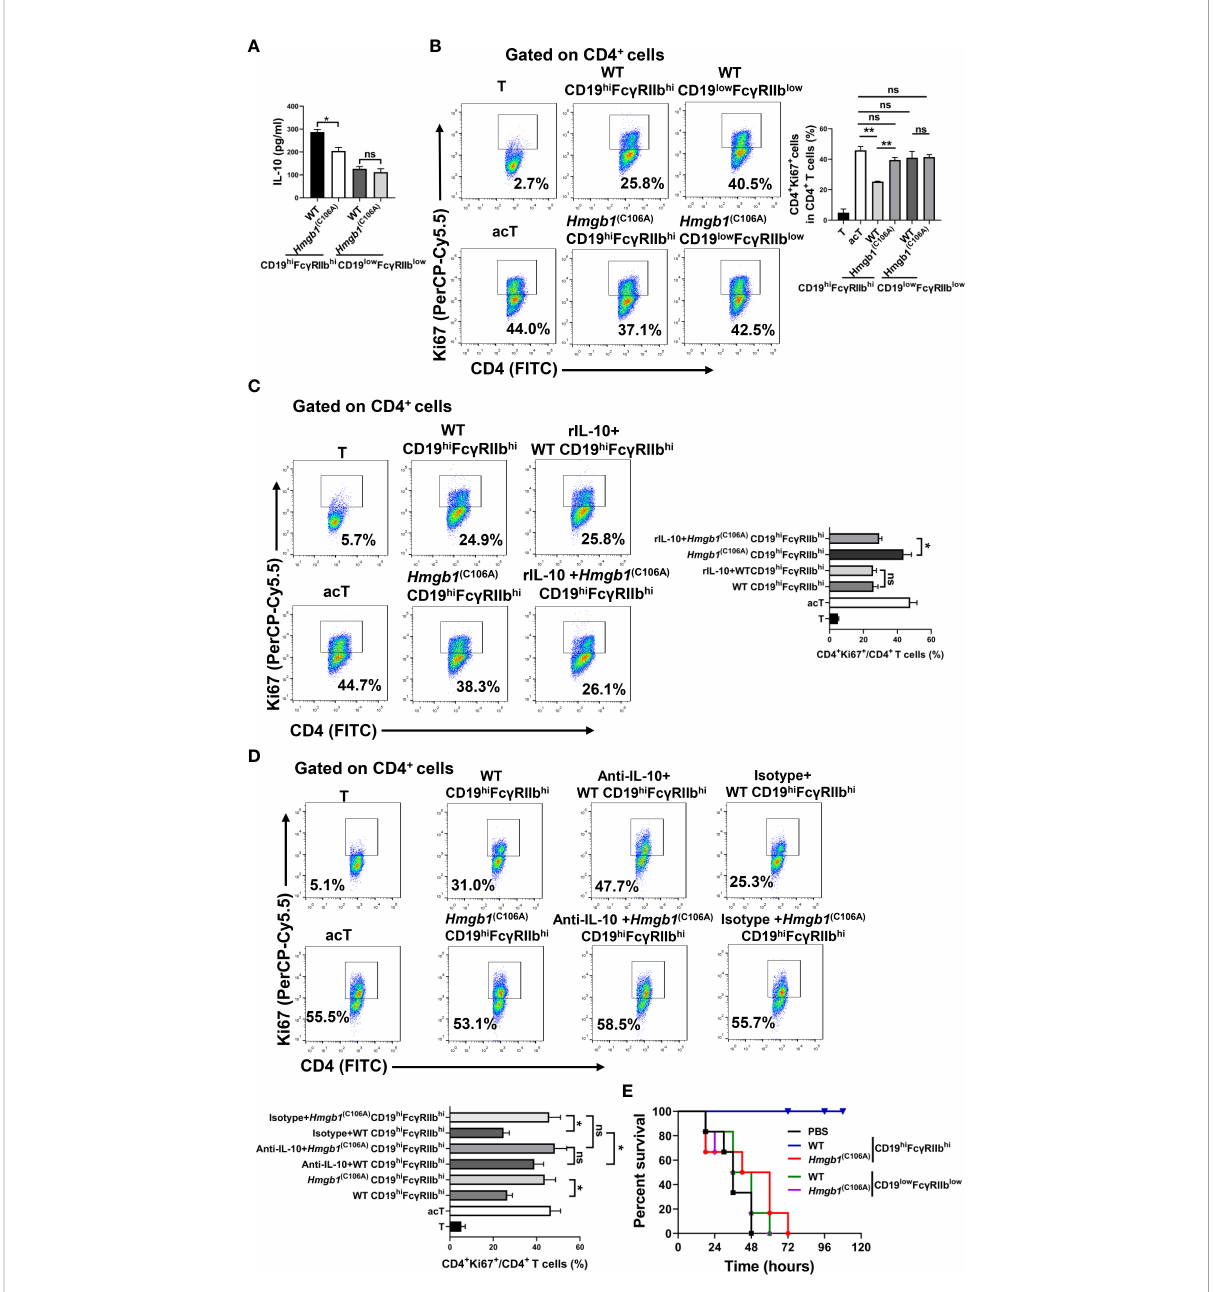
FIGURE 2 Hmgb1 (C106A) inhibited the suppressive function of CD19 hi Fc g RIIb hi B cells in mice. WT and Hmgb1 (C106A) mice were injected with LPS on day 0. On day 7, splenic CD19 hi Fc g RIIb hi B cells and CD19 low Fc g RIIb low B cells were sorted by fl ow cytometry. (A) CD19 hi Fc g RIIb hi B cells or CD19 low Fc g RIIb low B cells (2 × 10 5 ) were plated on 96-well plates. After 24 h, supernatants were collected for measurement of IL-10 levels by ELISA. Data are shown as means ± SEMs of three independent experiments. (B – D) Puri fi ed CD19 hi Fc g RIIb hi B cells (2 × 10 5 ) from LPS-treated mice were cocultured with anti-CD3/CD28-activated CD4 + T cells (2 × 10 5 ) (B) in the presence or absence of rIL-10 (C) or anti-IL-10 (D) . After 48 h, CD4 + T cell proliferation was determined by Ki67 staining and fl ow cytometry. Representative histograms show Ki67 expression by CD4 + T cells and the proliferation of CD4 + T cells. Data are shown as means ± SEMs of three independent experiments. (E) C57BL/6 mice were injected with puri fi ed CD19 hi Fc g RIIb hi B cells or CD19 low Fc g RIIb low B cells from LPS-treated WT and Hmgb1 (C106A) mice; PBS served as the control condition. After 1.5 h, LPS (15 mg/kg) was injected into the mice to induce sepsis, and mortality was monitored. Survival analysis was performed by log-rank (Mantel – Cox) tests; n = 6 mice per group. *P < 0.05; **P < 0.01; NS, not signi fi